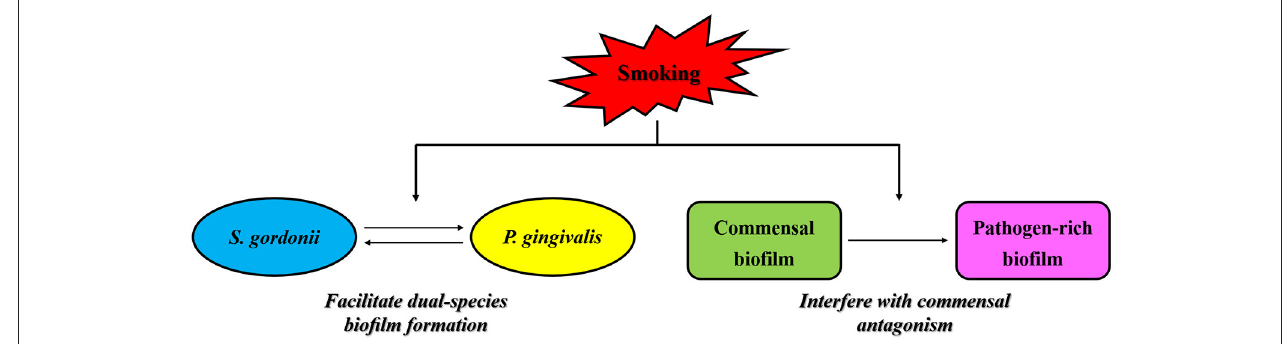
FIGURE 2 | Effects of smoking on interspecies interaction in subgingival plaque. Smoking is reported to facilitate P. gingivalis - S. gordonii dual-species biofilm formation via enhancing the binding of P. gingivalis FimA to glyceraldehyde-3 phosphate dehydrogenase, the cognate FimA ligand on S. gordonii , in a dose-dependent manner. Moreover, smoking is observed to interfere with the antagonistic effects of commensal microbes on periodontal pathogens via a mechanism in which smoke exposure could induce significant transcriptional shifts in commensal biofilms and trigger a florid pro-inflammatory response leading to early commensal death, thus contributing to the formation of pathogen-rich subgingival biofilms and the subsequent development of periodontitis in